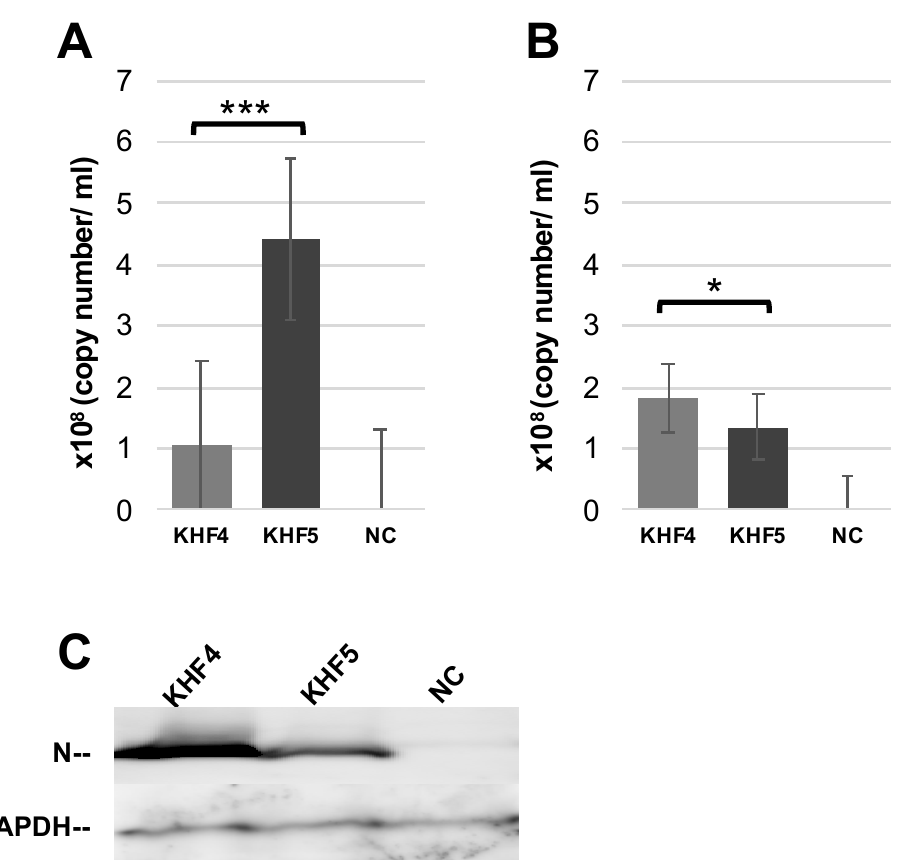
Figure 5. KHF4 and KHF5 replication in lung tissue. ( A ) Lungs were collected from KHFV-infected mice at 5 dpi and cultured. After 7 days, the supernatant was collected for real-time RT-PCR. ( B ) Uninfected BALB/c mouse lungs were collected and cultured as described above. After infection with KHFV, the supernatant was collected at 7 dpi for real-time RT-PCR analysis. ( C ) Viral N protein in the lung tissue as shown in Figure 5B detected by Western blot. Results from mock inoculated mouse and lung tissue are shown in NC (Significance was assigned as * p < 0.05, and *** p < 0.001). 3.5. KHF5 Infection Caused Renal Hemorrhage, Lung Edema, and Acute Hepatitis As reported previously [21], KHF5 infection causes renal hemorrhage. As KHFV tar- geted the lungs and both strains showed high infectivity to the liver, viral N antigens were analyzed by IHC to examine the distribution of viruses in the lung, liver, and kidneys. In the KHF5-infected lungs of mice, viral antigens were detected in alveoli and bronchial epithelial cells, compared with the negative control and KHF4-infected lungs. KHF5 in- fection caused severe pneumonia, and aggregation of lymphoid cells was identified near the peri-bronchus edema. Additionally, mononuclear cell infiltration with KHFV antigens was found in capillary vascular endothelial cells (Figure 6A). As both strains showed high infectivity in the liver, the viruses caused acute hepatitis due to lymphocytic infiltration of inflammatory cells. Reduced glycogen storage and petechial hemorrhage were ob- served in KHF5-infected mice alone (Figure 6B). Focal interstitial hemorrhage was ob- served in the renal medulla, cortex, and tubular region in KHF5-infected mice alone, and viral antigens were detected mainly in the tubular region (Figure 6C).